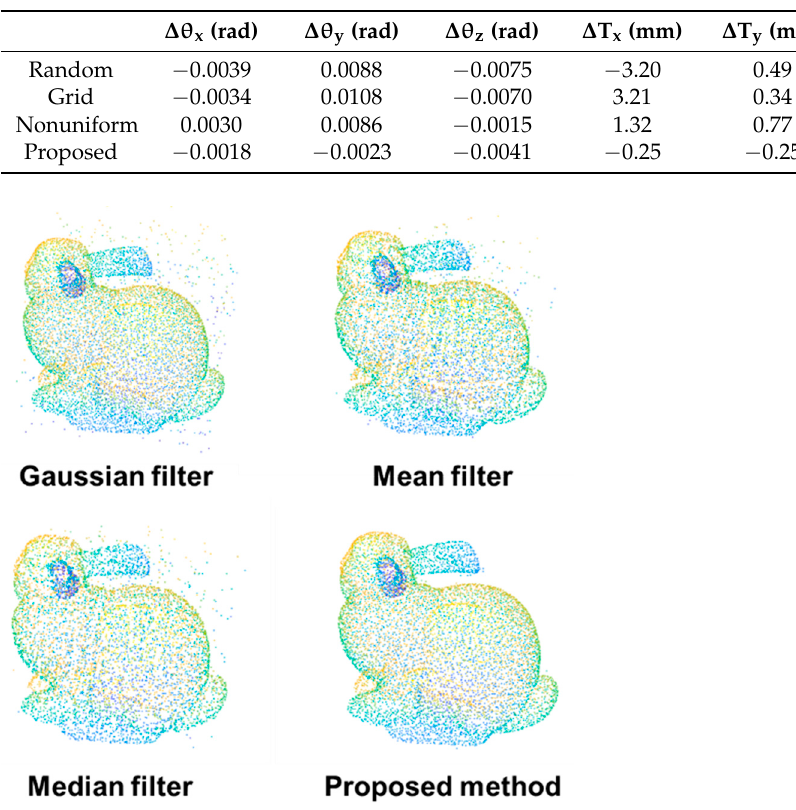
Figure 4. Comparison of the alignment accuracy of different resampling methods. Table 1. Comparison of the alignment accuracy.